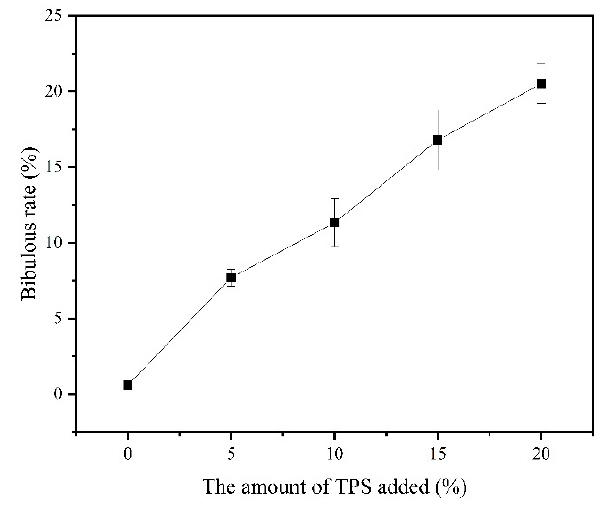
Figure 8. E ff ect of TPS content on the water absorption of composite Figure 8. Effect of TPS content on the water absorption of composite films.